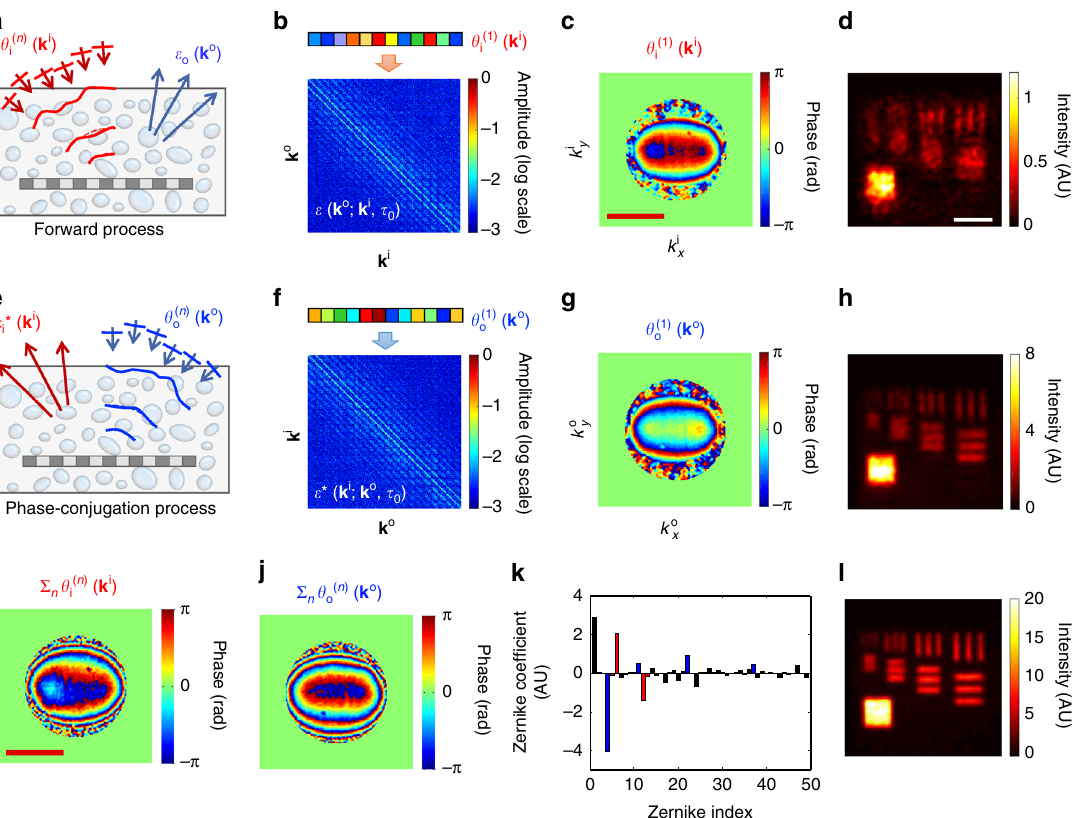
Fig. 3 Experimental demonstration of suppressing both scattering and aberration. a Diagram of aberration correction for the forward process in which (cid:1) (cid:3) (cid:1) (cid:3) i phase correction θ ð n Þ is applied to each k i . Here n is the iteration number. b The application of phase correction θ ð 1 Þ to the columns of the time- k i (cid:1) (cid:3) (cid:1) (cid:3) i k i i resolved re fl ection matrix, E k o ; k i ; τ 0 . c Phase map of θ ð 1 Þ that maximized the total intensity of reconstructed image in the fi rst round of iteration. i k Color bar, phase in radians. Scale bar, k 0 α . d Reconstructed image after applying for the phase correction identi fi ed in ( c ). Scale bar, 4 μ m. e Diagram of aberration correction in the phase-conjugation process in which the phase correction θ ð n Þ k o ð Þ is applied to each k o in the reversal process. f The application (cid:1) (cid:3) o of phase correction θ ð 1 Þ . g Phase map of θ ð 1 Þ k o ð Þ to the columns of the phase-conjugated re fl ection matrix E (cid:6) k i ; k o ; τ 0 k o ð Þ that maximized the total o o intensity of the image in the fi rst round of iteration. h Reconstructed image after applying for the phase correction identi fi ed in ( g ). i , j Accumulated phase- correction maps for the illumination and imaging paths, respectively, after n = 5 rounds of iterations. k Decomposition of the map in ( j ) into the fi rst 50 Zernike polynomials Z j following the convention of Noll ’ s sequential indices. Blue bars indicate spherical aberrations ( j = 4, 11, 22, 37), and red bars astigmatisms ( j = 5, 6, 12, 13). l Reconstructed image after 5 rounds of iterations. Color bars for the images in ( d , h , i ) are the intensity normalized by